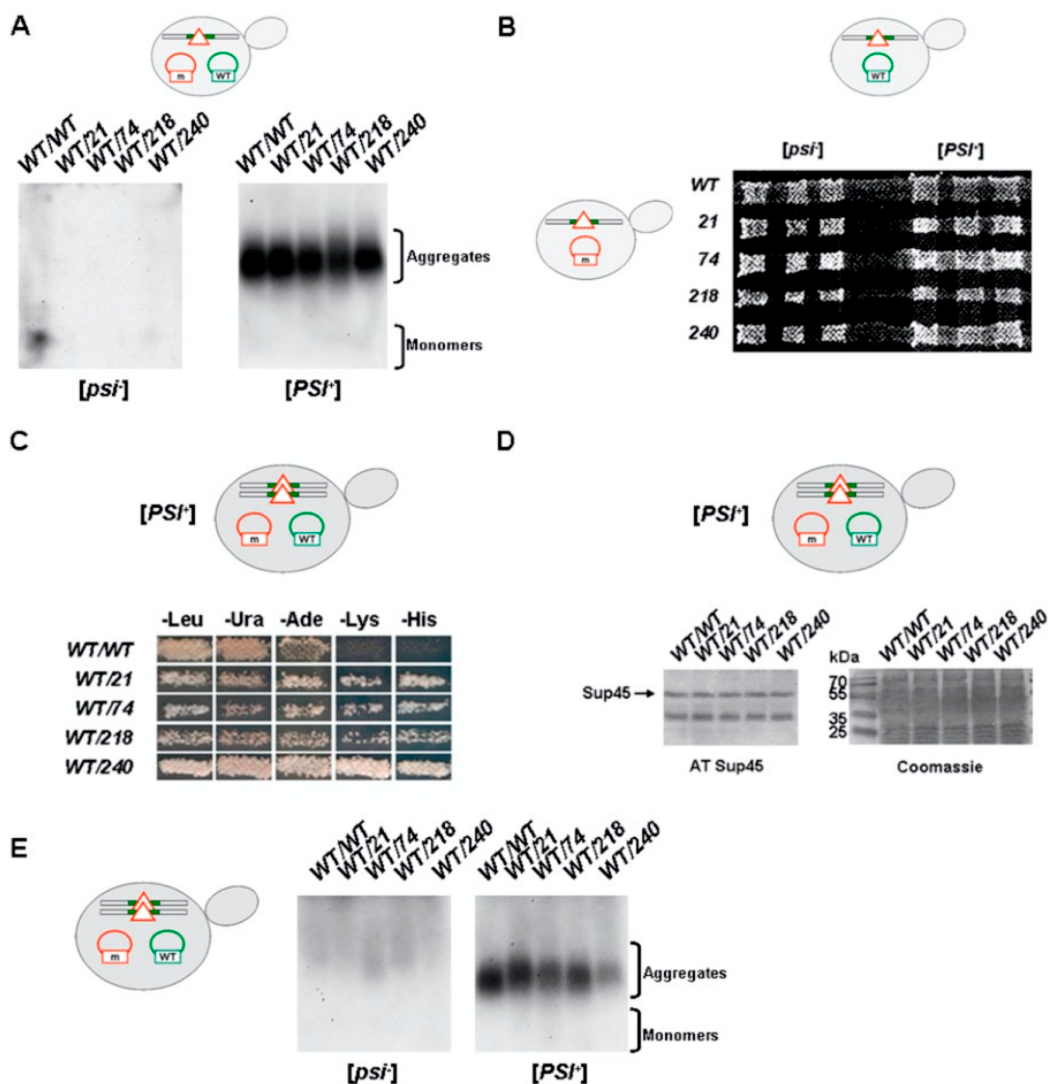
Figure 3. Nonsense mutations in the SUP35 gene do not affect [ PSI + ] maintenance in the presence of wild-type SUP35 . ( A ) Yeast cell lysates from transformants containing the plasmid with the SUP35 gene in combination with the plasmid carrying the indicated mutant allele were characterized by SDD-AGE followed by Western blotting with anti-Sup35 antibodies. ( B ) Mating of [ psi − ] or [ PSI + ] haploid cells bearing plasmid with wild-type SUP35 (vertical lines) with [ psi − ] cells containing mutant plasmids (horizontal lines) leads to the formation of viable [ psi − ] and [ PSI + ] diploids after 5 days of incubation at 30 °C. ( C ) SUP35 / sup35-n [ PSI + ] diploids are able to grow on media selective for nonsense suppression after 5 days of incubation at 30 °C. Media without leucine (-Leu) or uracil (-Ura) were used to control the presence of both plasmids. Ten independent transformants were tested in each case, representative results are shown. ( D ) Diploid [ PSI + ] strains containing two plasmids have the equal Sup45 amount. The same transformants as on the Panel C were tested by Western blotting. Coomassie staining of the same gel was used as a loading control. ( E ) Yeast cell lysates from diploids shown on the Panel B were characterized by SDD-AGE with immunoblotting for Sup35.